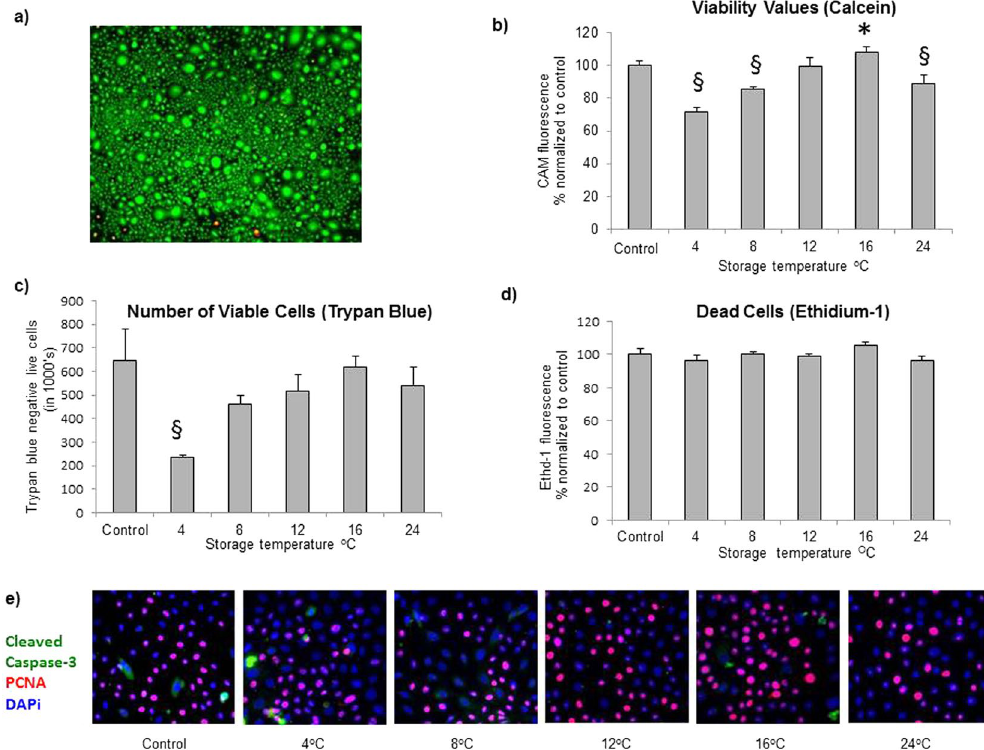
Figure 2. Viable and dead cells. ( a ) Representative live (CAM)/dead (EthD-1) fluorescence image in control cells (X40). The fluorescence value from the live ( b ) and dead ( c ) cells in control are represented as 100% in graphs for comparison with temperature groups. ( b ) The number of live cells, indicated by CAM fluorescence ( * = significantly increased compared to control; § = significantly decreased compared to control; p ≤ 0.05). ( c ) The number of dead cells, indicated by EthD-1 fluorescence. ( d ) The number of viable cells using trypan blue ( § = significantly decreased compared to control; p ≤ 0.05) ( e ) Expression of PCNA and activated